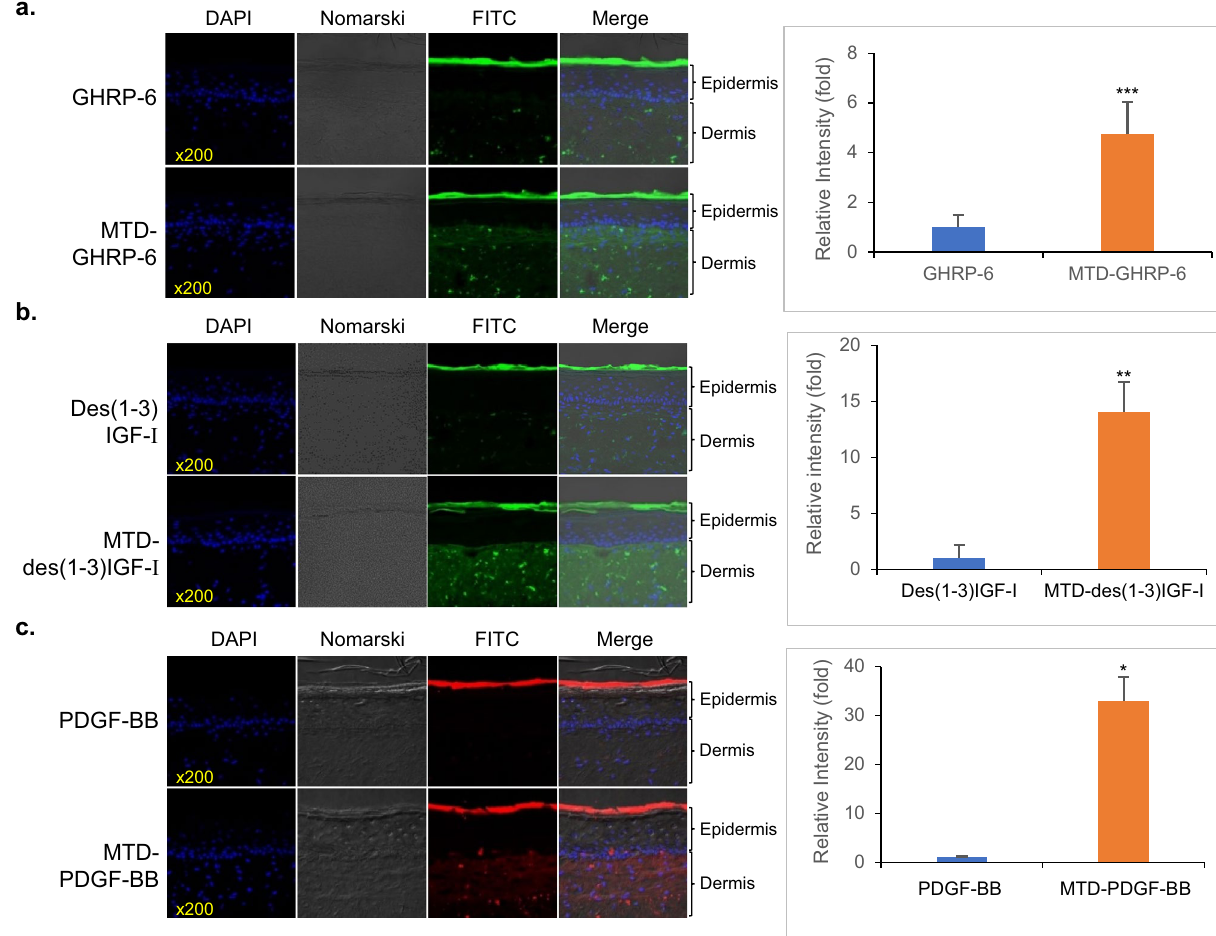
Figure 6. Transdermal delivery of MTD 1067-conjugated peptide and recombinant proteins in artificial skin model. Comparison of skin penetration (left) and permeability analysis using fluorescence intensity on the confocal image (right) were made with ( a ) FITC-labeled GHRP-6 and MTD-GHRP-6, ( b ) FITC-labeled des(1-3)IGF-I and MTD-des(1-3)IGF-I, ( c ) Rhodamine-labeled PDGF-BB and MTD-PDGF-BB. Each of the fluorescence intensity values per equivalent area are expressed as mean ± S.E. based on analysis of at least three independent images. Asterisks indicate statistical significance compared with the cargo control, as determined by the student’s t-test (*p < 0.05, **p < 0.01, ***p <